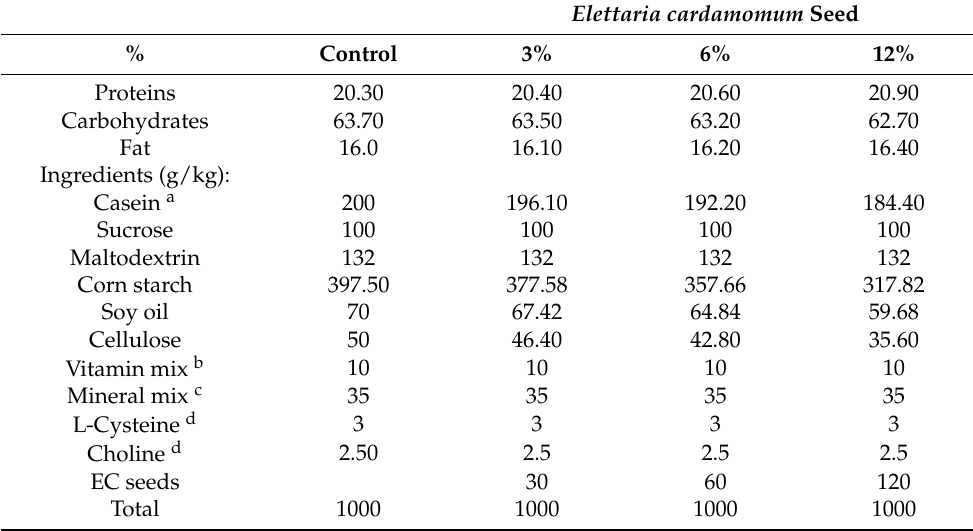
Table 3. Composition of experimental